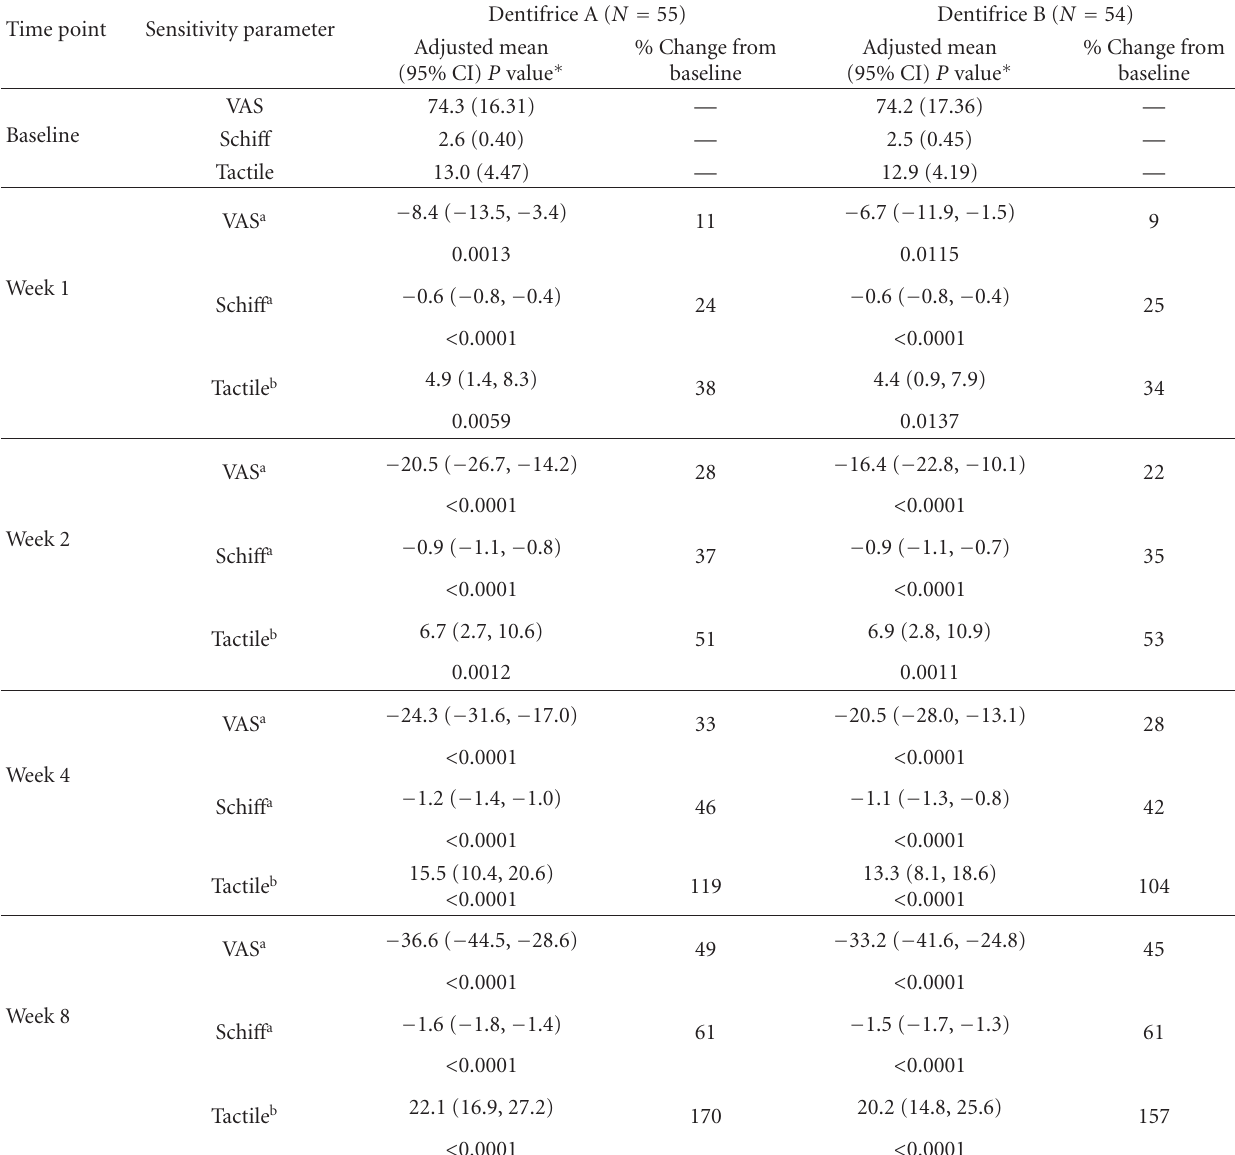
Table 1: Summary of change from baseline in e ffi cacy measures within each treatment group; Dentifrice A = Sensodyne Multi Action Iso- Active, Dentifrice B = Colgate Sensitive Pro-Relief. ∗ From ANCOVA model with the following factors: treatment, baseline VAS stratification value (for Schi ff and Tactile analyses), number of air sensitive teeth (covariate), and baseline (covariate). a Negative values favour Dentifrice A. b Positive values favour Dentifrice A. Baseline values are raw means